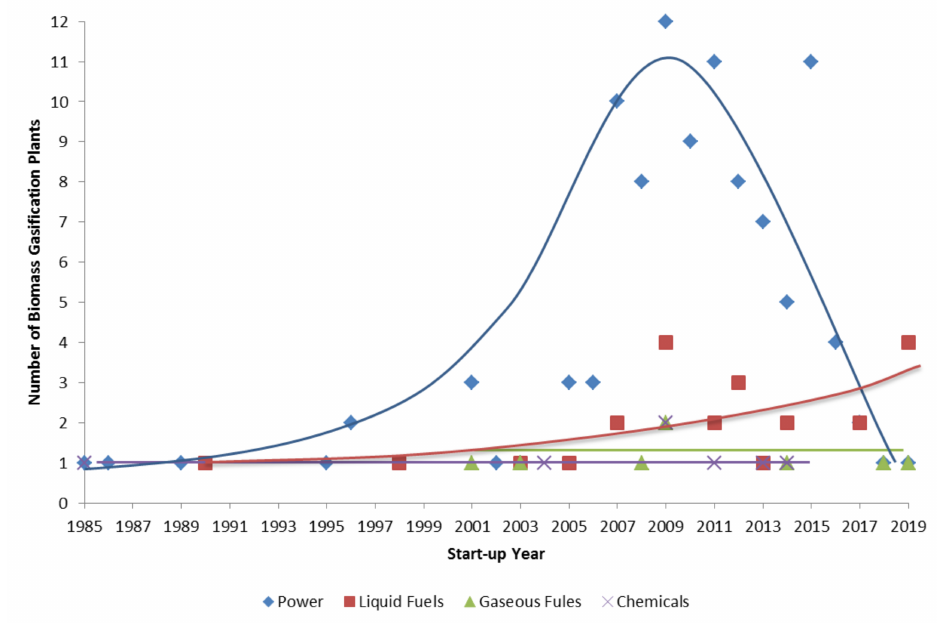
Figure 2. Trend of number of biomass gasification plants (operational/idle/on hold/under construction/ planned) as a function of start-up time—trend lines are qualitative (self-processed data from IEA T33 database